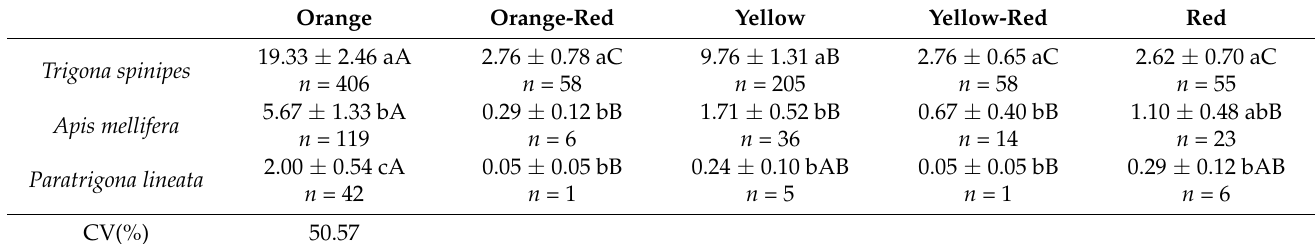
Table 1. Abundance of visiting bee species in Tropaeolum majus flowers of different